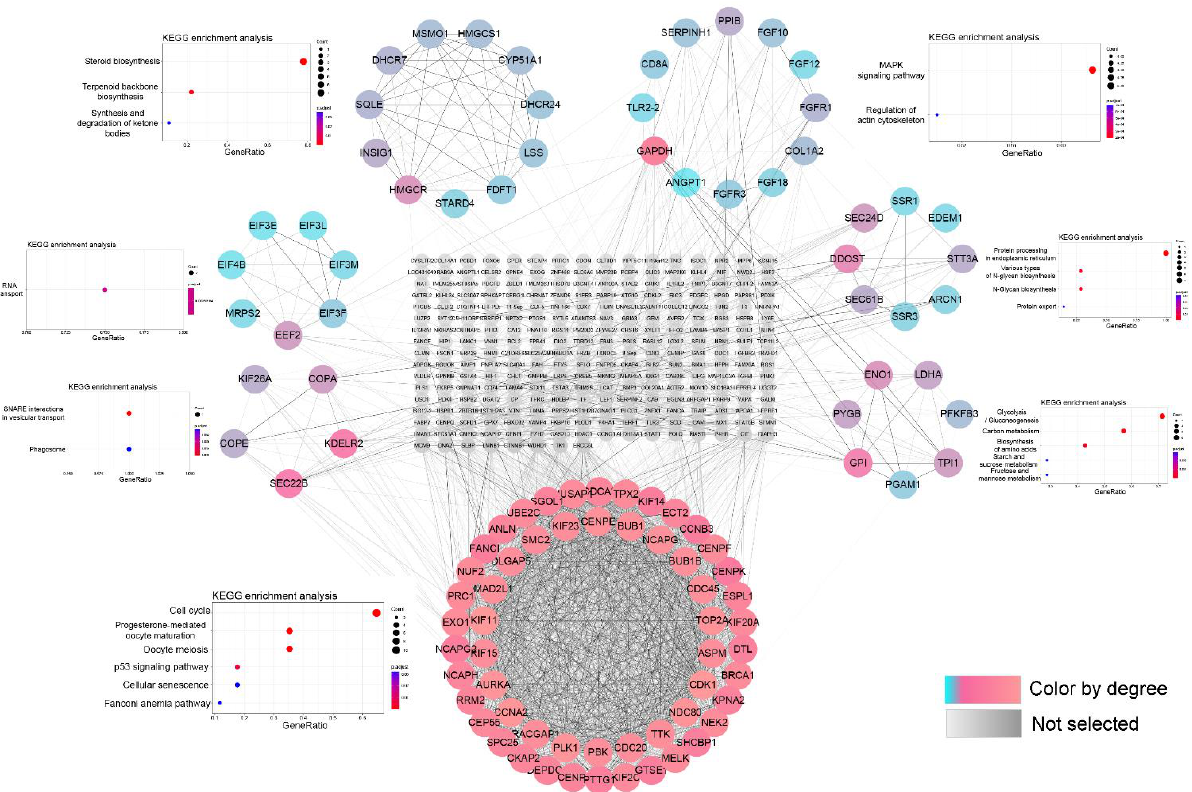
Figure 3. Seven modules extracted from Protein–Protein Interaction (PPI) network and KEGG enrichment analysis. The colors from pink to blue represent the degree of gene connectivity.